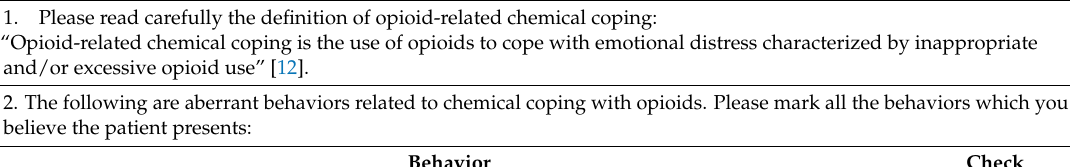
Table 1. Opioid-related chemical coping definition and questionnaire for